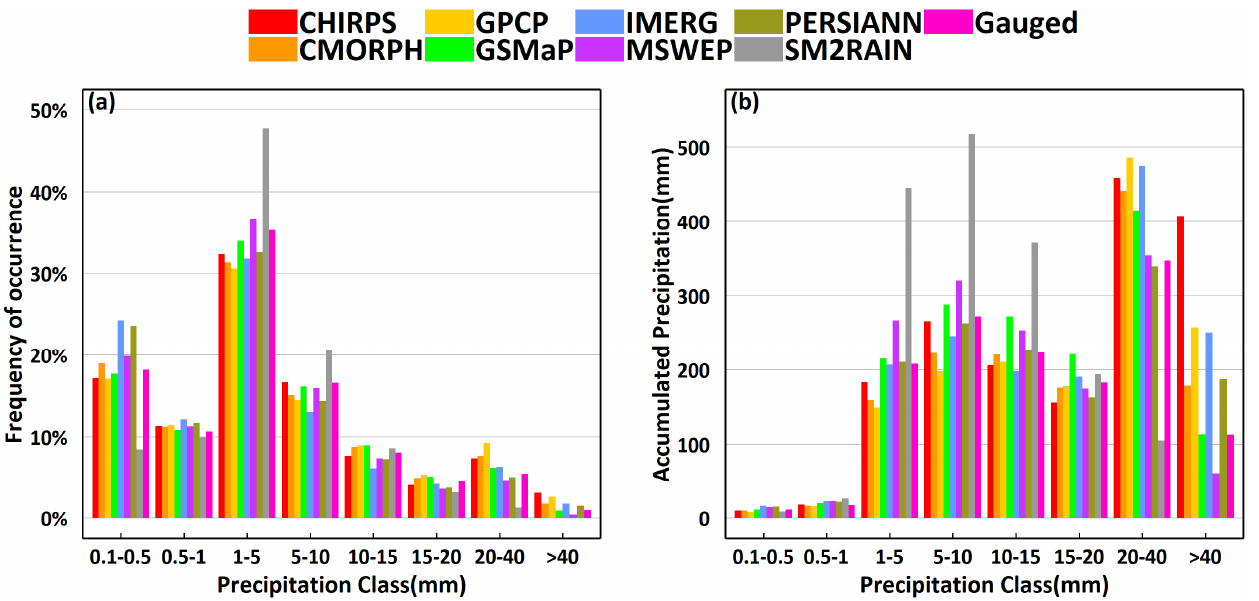
Figure 5. The frequency distribution of precipitation ( a ) and accumulated precipitation distribution annually ( b ) in XJRB from 2007 to 2020 for different precipitation datasets under different precipitation intensity classes.